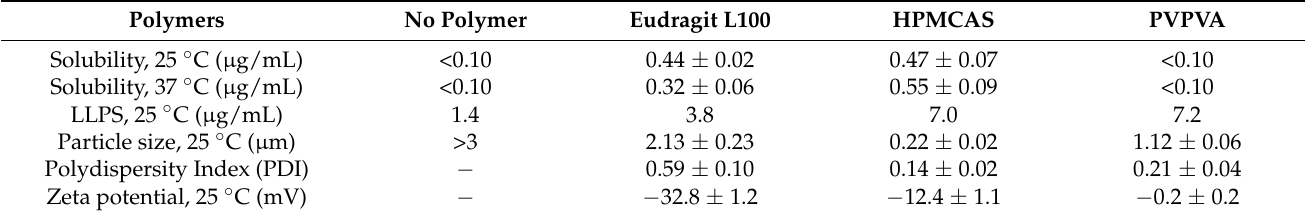
Table 2. Solution/suspension properties of ALZ in PB (pH7) in the presence and absence of polymers.